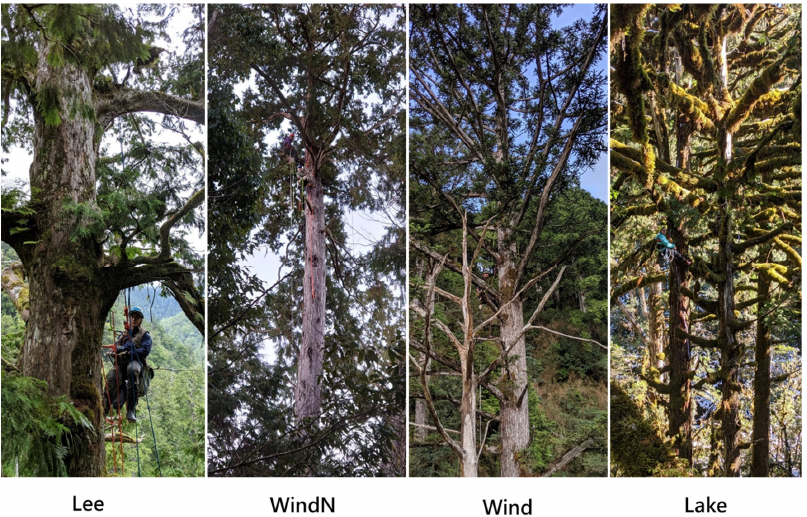
Figure 2. The old ‐ growth forests of the four sites in this study. Five emergent trees (with heights of 19~46 m and DBH 73~230 cm) were chosen at each site for epiphytic plant inventory and microclimate monitoring. Host trees at the Lake site had abundant bryophyte cover, and trees at the WindN and Lee sites were significantly taller and larger than trees at the other two